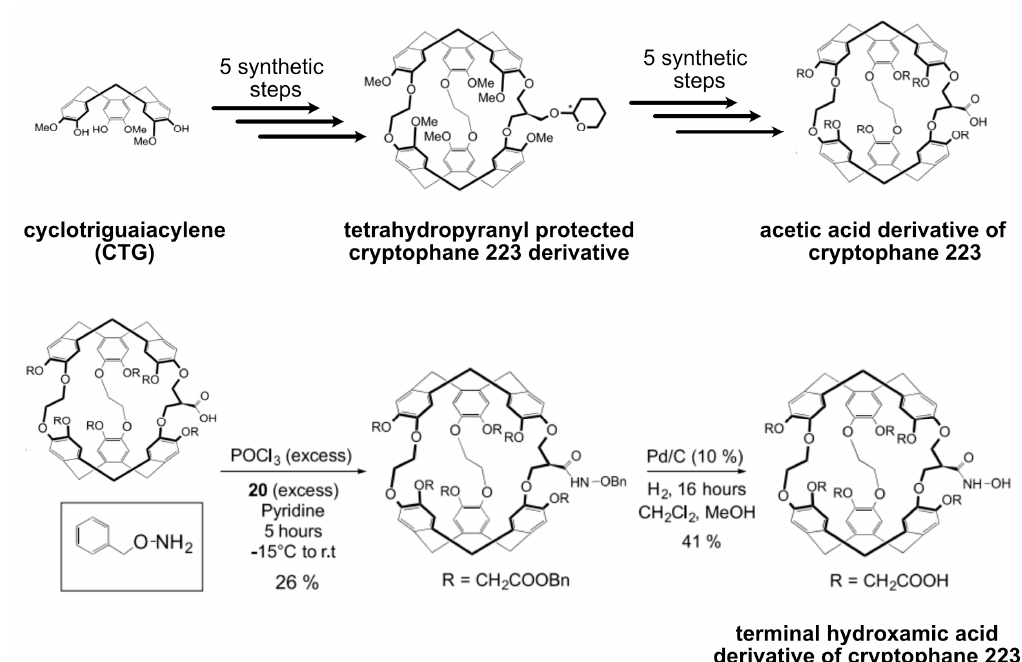
Figure 9. Summary of important synthetic steps involved in the synthesis of novel and functionalizable cryptophane 223 derivatives. The final compound containing terminal hydroxamic acid along with six acetic acid confers water solubility and also enables recognition of specific cationic species (e.g., metal cations) in solution. In this way, while preserving the Xe binding to the host cavity, the functionalization can be carried out more e ffi ciently at the single arm of cryptophane 223 than that of cryptophane 222 (CryA), respectively. Figure adapted from Ref.